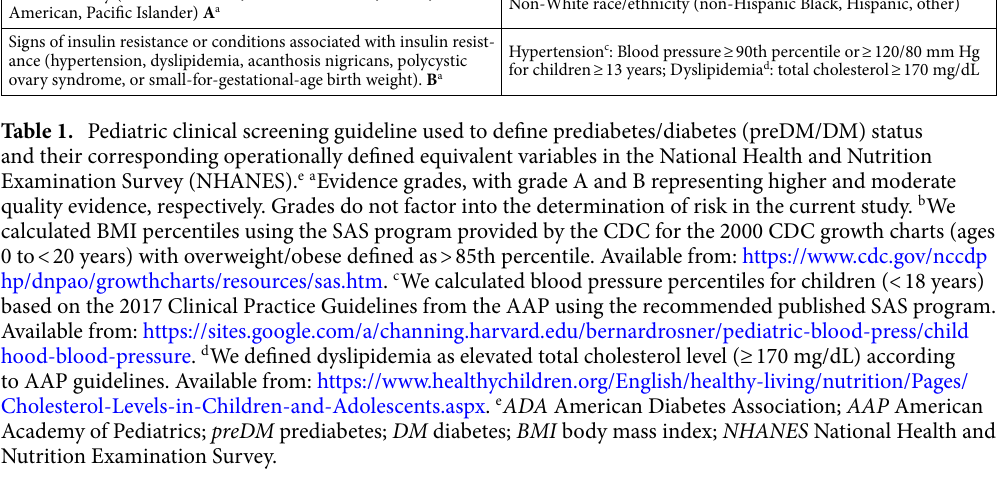
Table S2): sensitivity = 36.34%, specificity = 74.05%, PPV = 34.79%, NPV = 75.33%, and F-measures = 35.55% and 74.68% for those with and without preDM/DM, respectively. Similar performance variations across sex, race/ethnicity and age subgroups were also found on the weighted NHANES data (Supplementary Figure S2). Performance of ML‑based preDM/DM classifiers. Figure 2 shows the five-fold cross-validation 38 - derived results of classifying preDM/DM status using ML methods, variables used in the screening guideline, and class labels (preDM/DM or not) defined using biomarker criteria. Across almost all the methods and evalu-